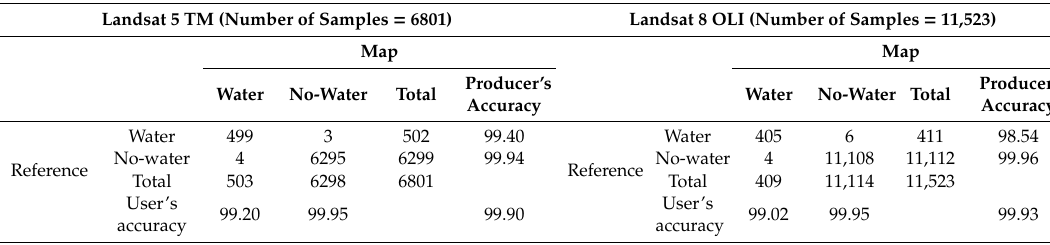
Table 2. The error matrix of TM and OLI water classification.